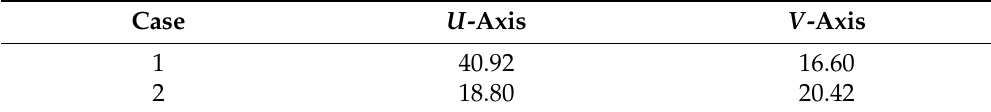
Table 5. Simulation 2: RMS errors.